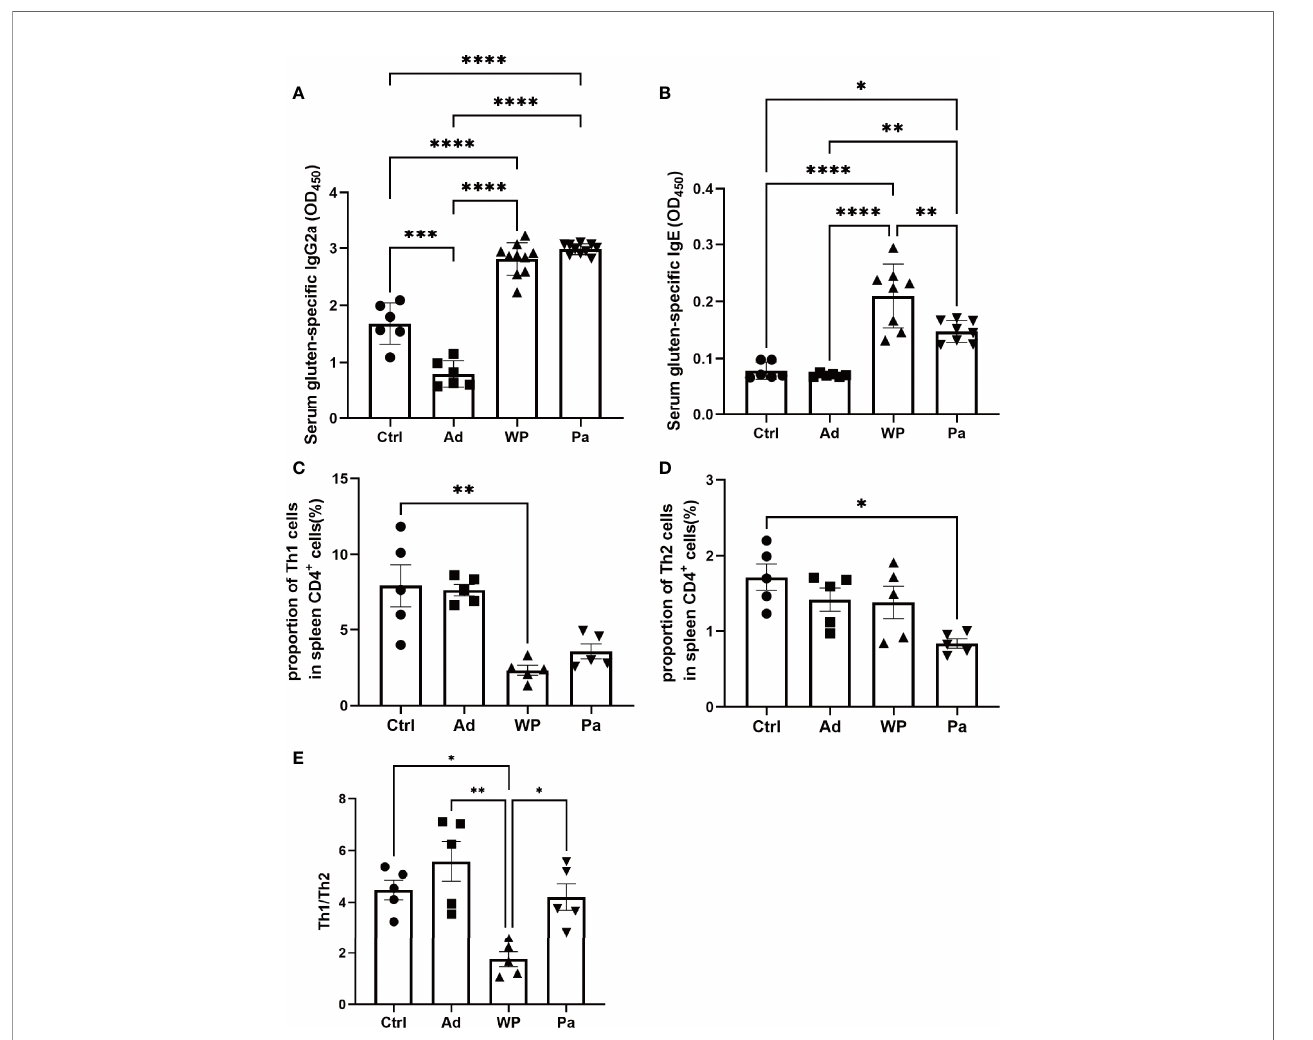
FIGURE 5 | Serum gluten-speci fi c IgG2a (A) and IgE (B) concentrations were measured by ELISA. The percentages of Th1 (C) and Th2 (D) in the spleens from different groups of mice were determined by FACS. (E) Th1/Th2 index. Data are shown as the mean value ± standard error of the mean ( n ≥ 5). The asterisk indicates a statistically signi fi cant difference ( P